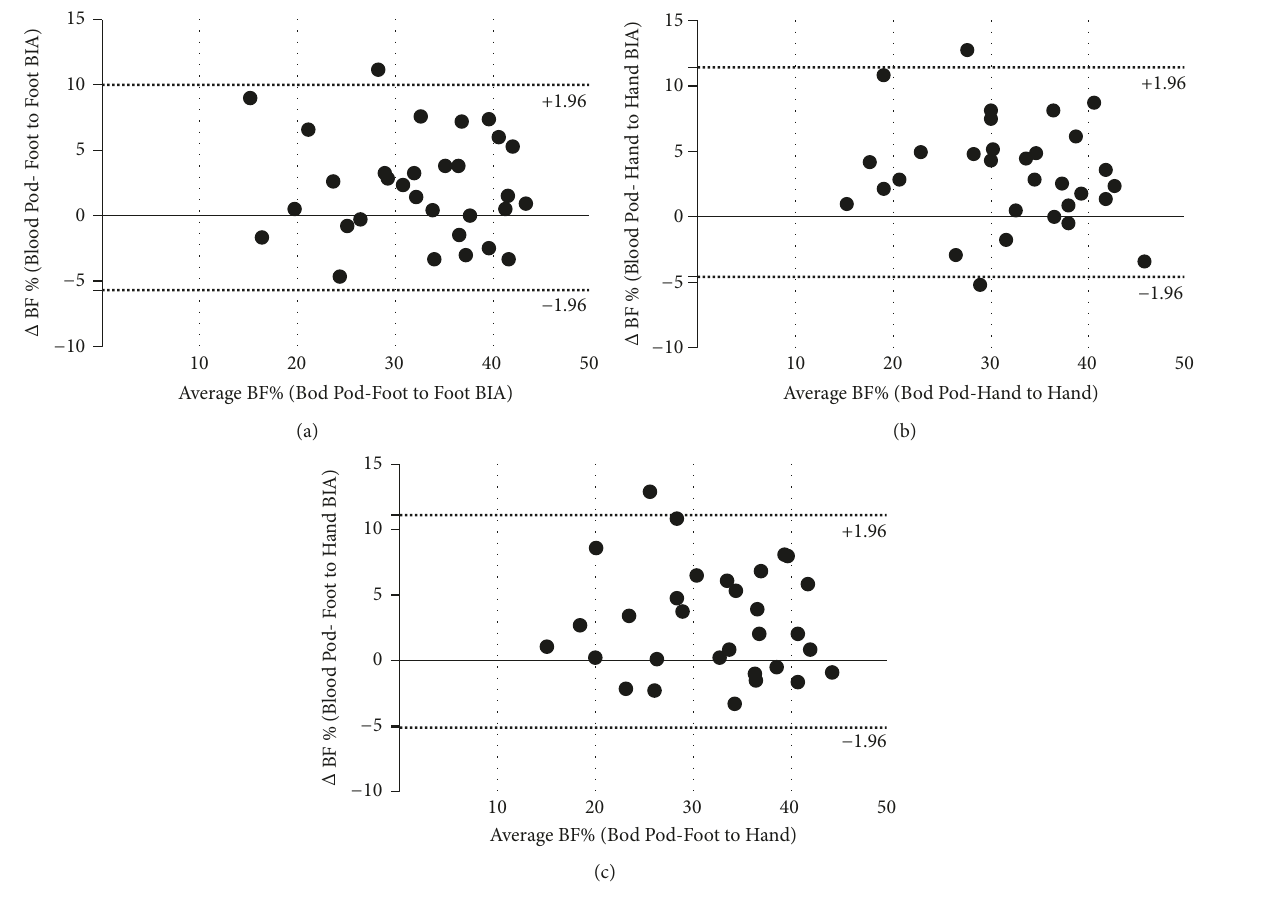
Figure 2: Tertile 3 of Hip Circumference Across BIA